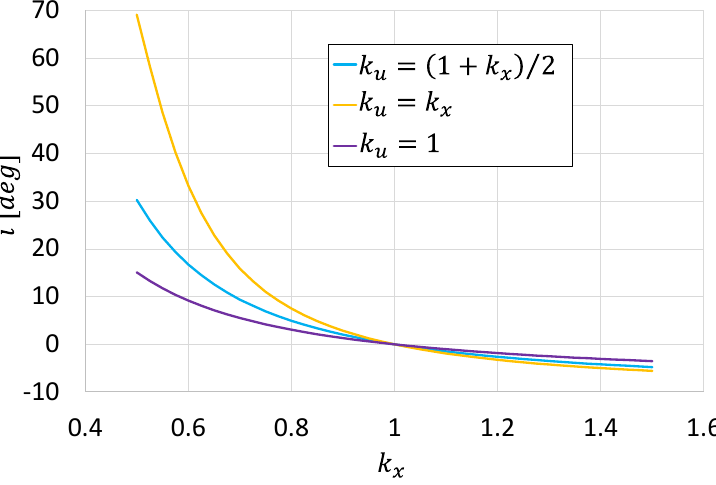
Figure 8. Incidence angle overflow rate range. Cases k u = 1, k u = k x , k u = ( 1 + k x )/2.